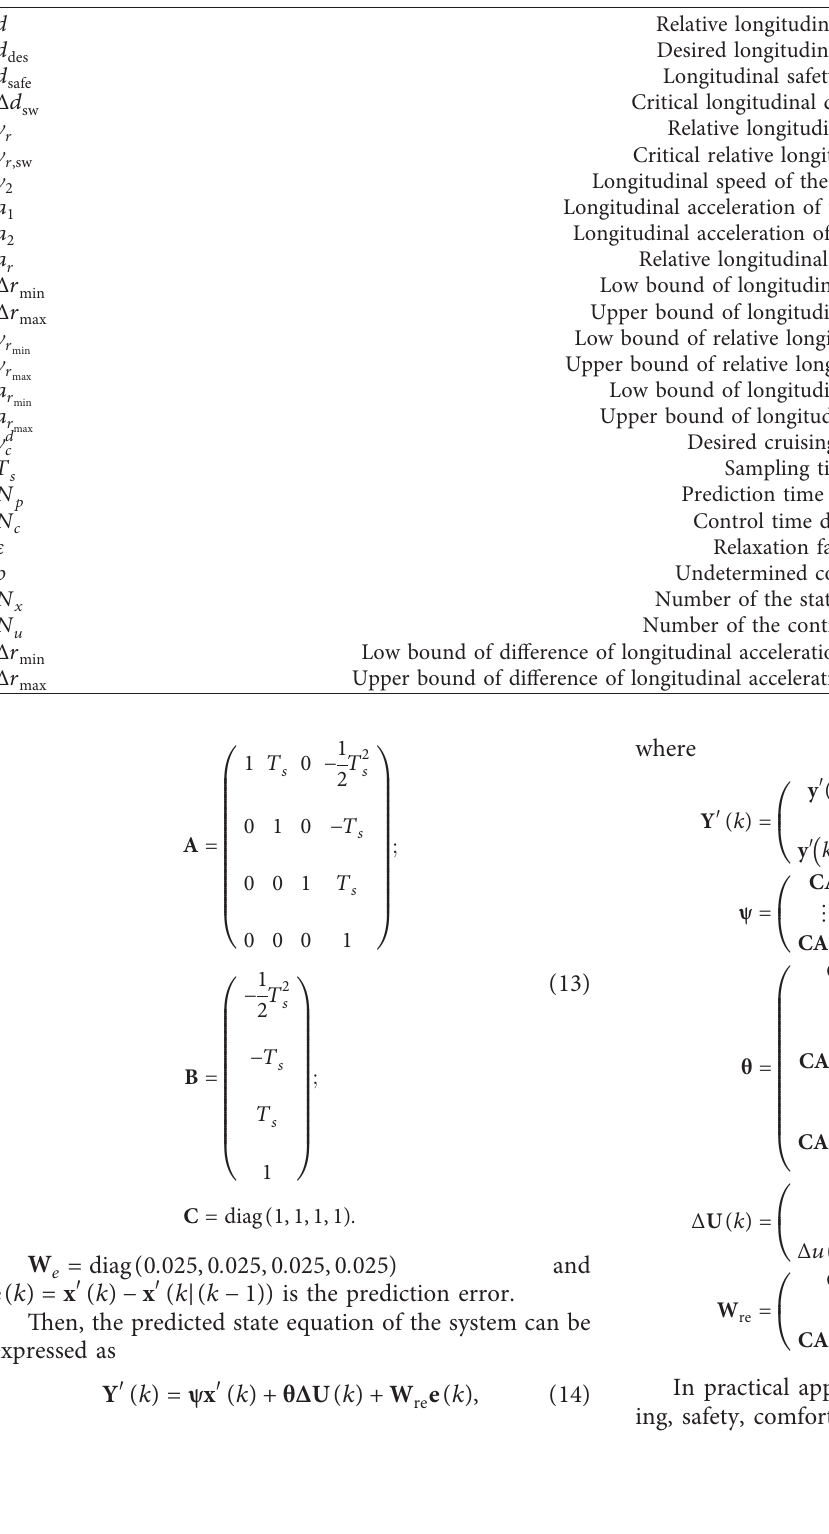
Figure 5: Scheme of the kinematic relations between the LV and the FV. Table 5: Parameters in the longitudinal dynamics controller